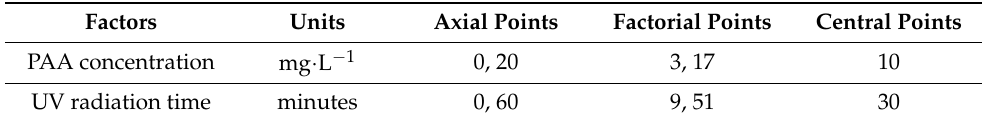
Table 1. Axial, factorial, and central points studied for different factors.